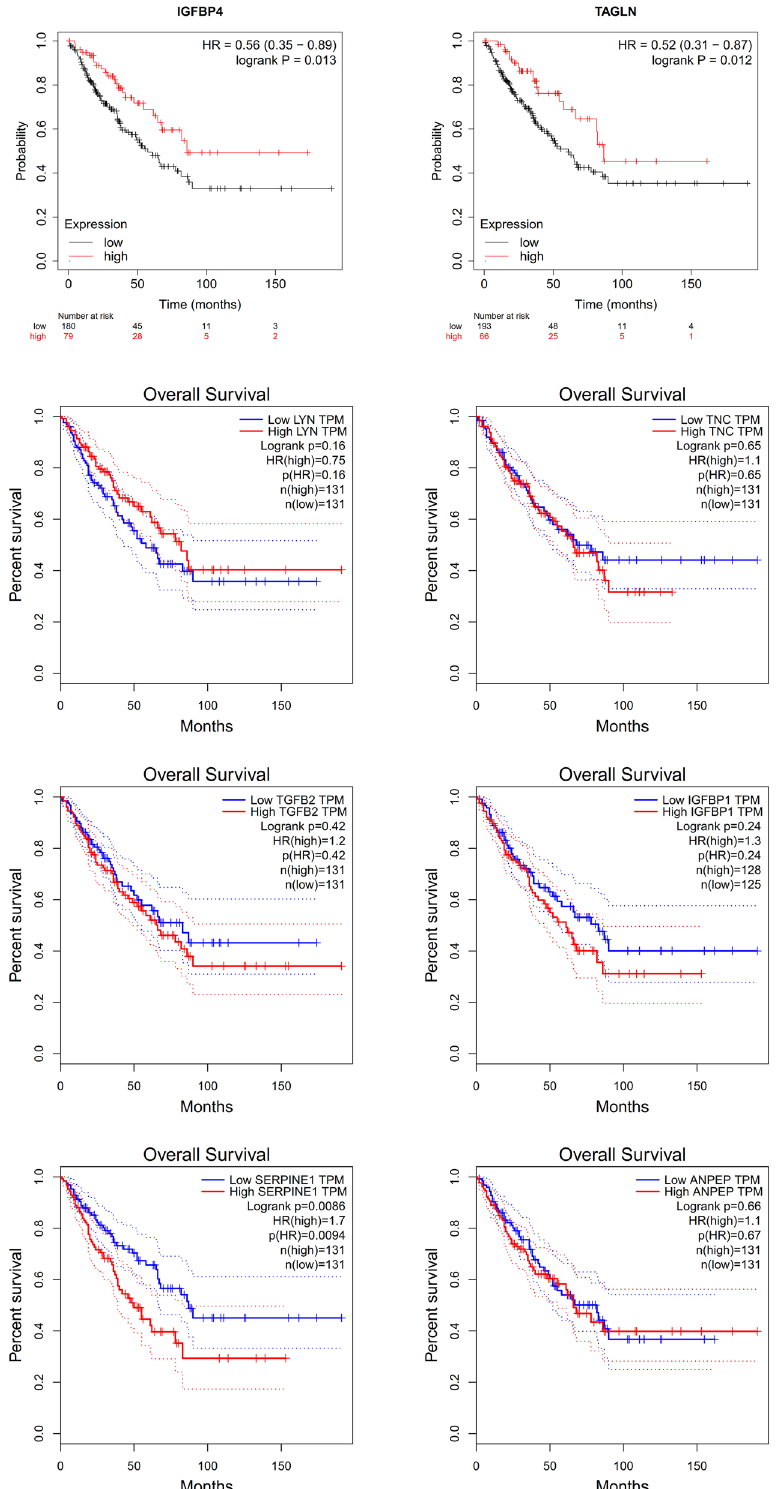
Figure 5. Effect of hub genes on the overall survival of